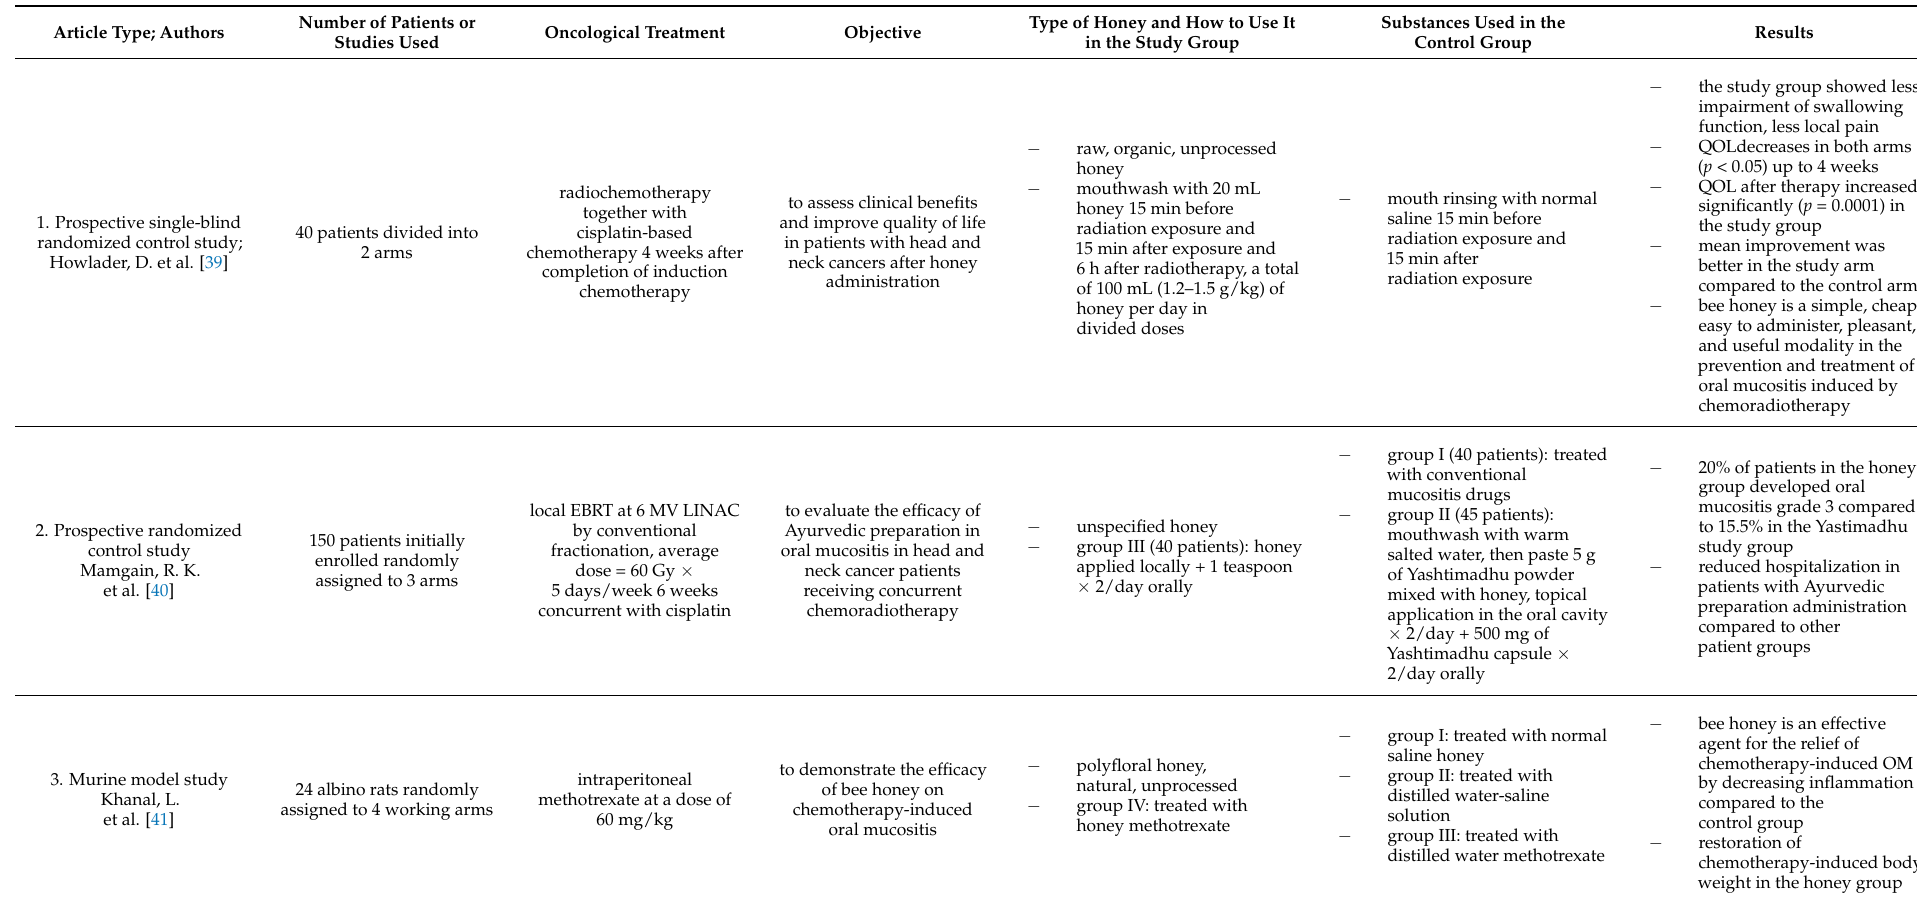
Table 2. Evidence regarding the effectiveness of bee honey in preventing and treating chemoradiotherapy-induced